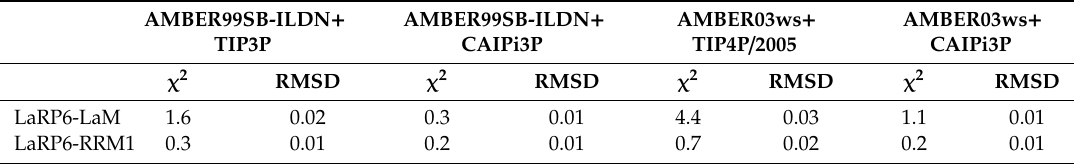
Table 4. Reduced χ 2 and RMSD metric for I / I 0 distribution for LaRP6 LAM and LaRP6